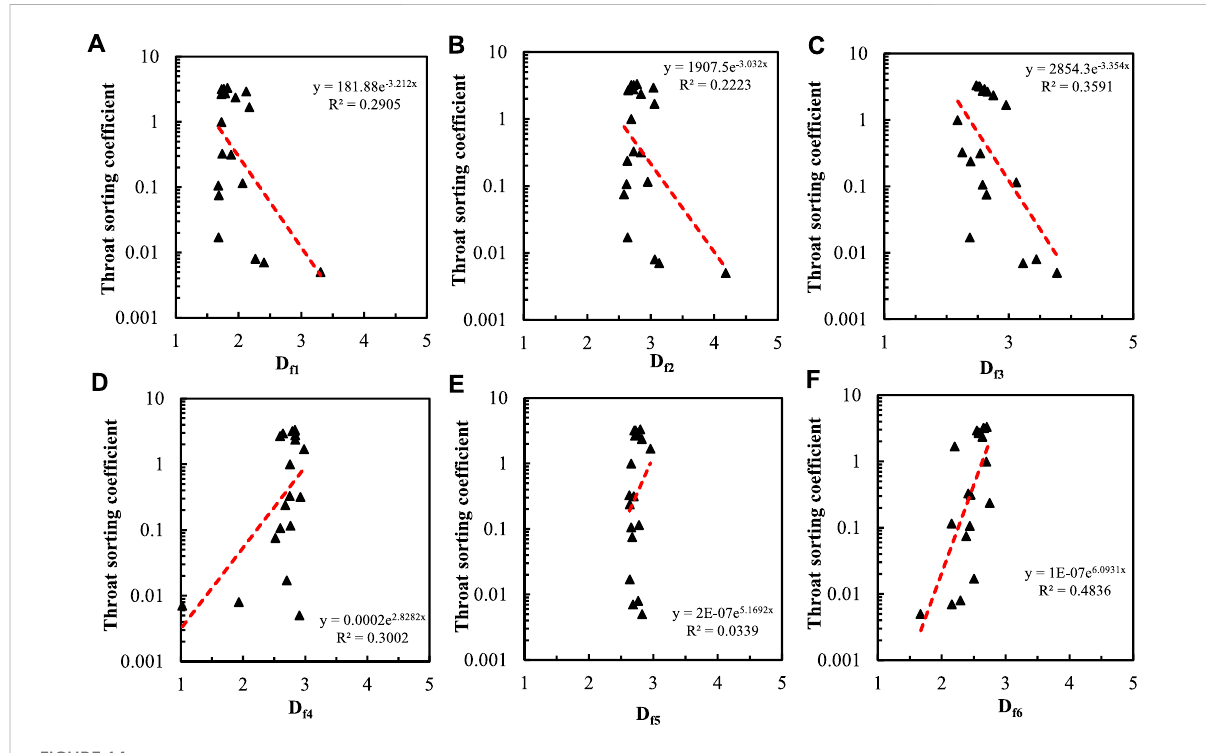
FIGURE 14 Relationship between throat sorting coef fi cient and fractal dimension calculated by six